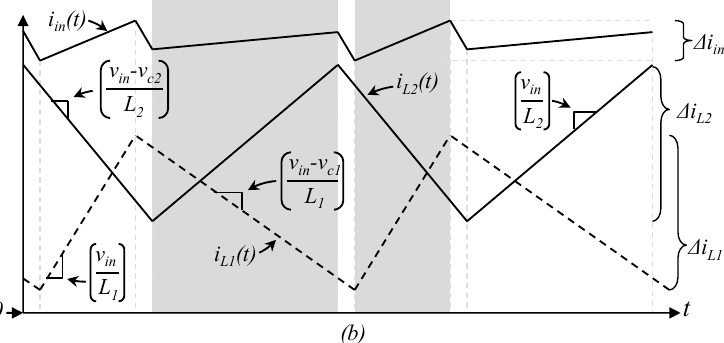
Figure 4. PWM important waveforms in the proposed converter when D > D Z .